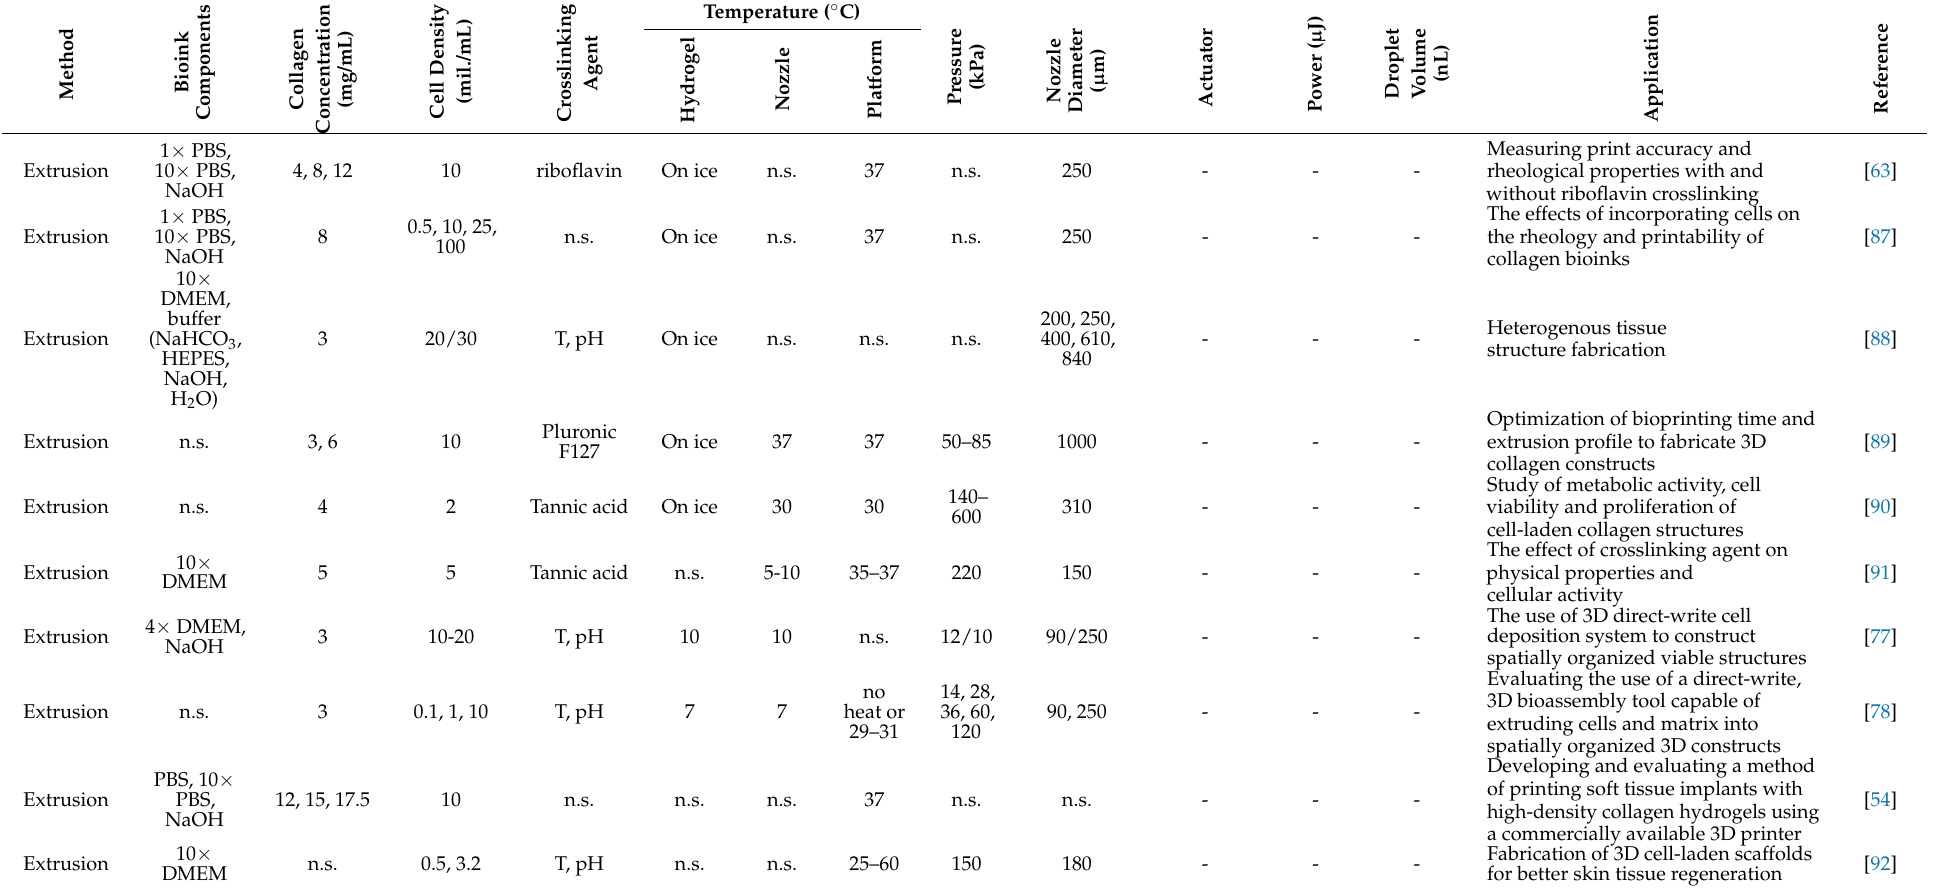
Table 1. Bioprinting parameters and other conditions of studies dealing with bioprinting of collagen bioinks. PBS—Phosphate Buffered Saline; DMEM—Dulbecco’s Modified Eagle Medium; Ham’s—F-12 Nutrient Mixture; HEPES—4-(2-hydroxyethyl)-1-piperazineethanesulfonic acid; EDTA—ethylenediaminetetraacetic acid; TBS—Tris-buffered saline. 10x—10x concentrated solution, 1x—1x concentrated solution; n.s.—the parameters were not specified by authors of study;—parameter not